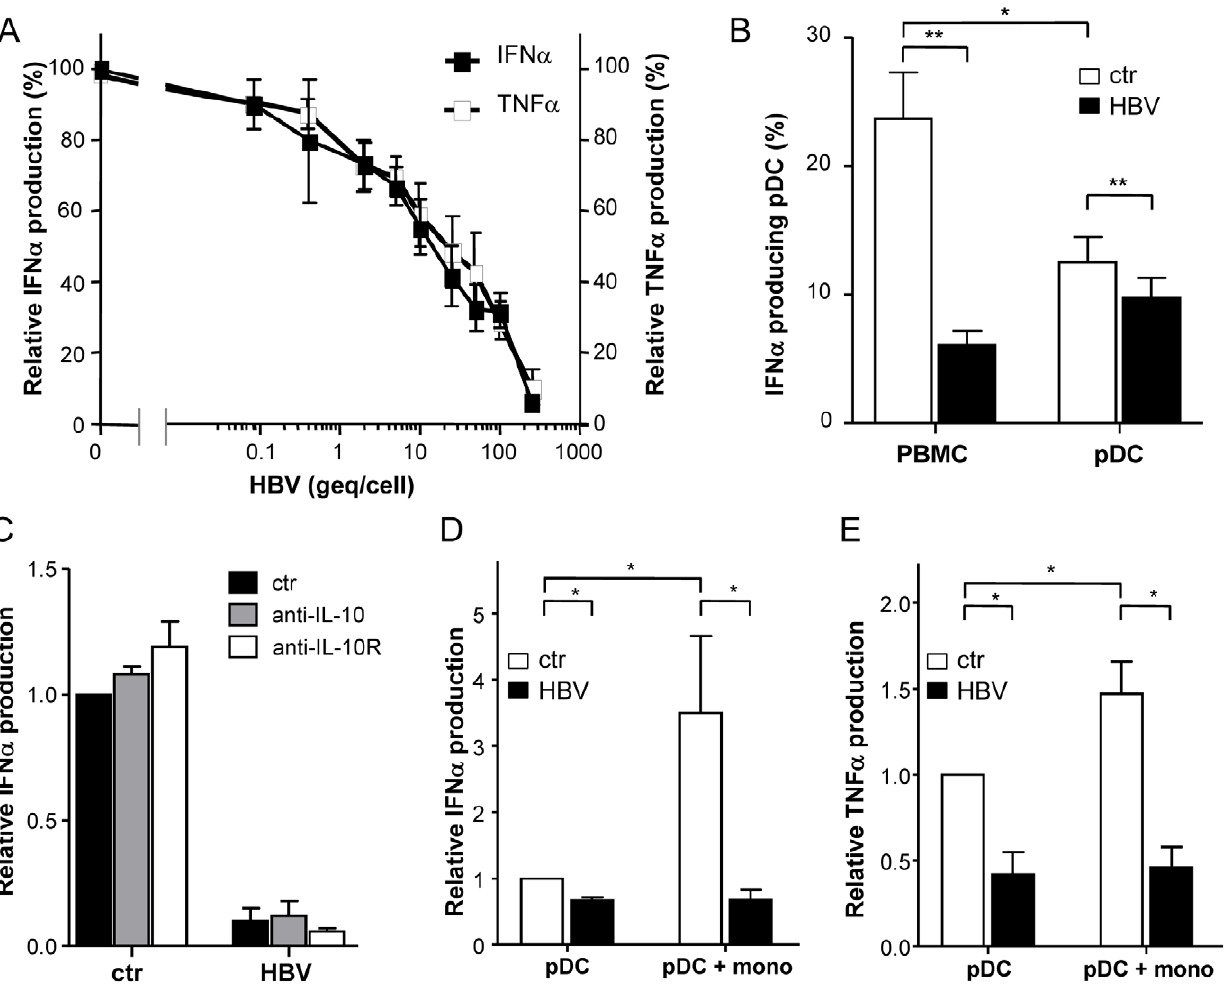
Figure 4. Monocytes support immune regulatory effect HBV on pDC. A : PBMC were stimulated with CpG with or without HepG2.215- derived HBV. Data present mean 6 SEM frequencies of IFN a and TNF a producing pDC of 6 independent experiments. B : PBMC or pDC were cultured with CpG with or without HepG2.215-derived HBV. Mean 6 SEM intracellular IFN a expression in pDC of 21 independent experiments is shown. *p=0.01, **p , 0.001, Wilcoxon signed rank test. C : PBMC were stimulated with CpG with or without HepG2.215-derived HBV and with or